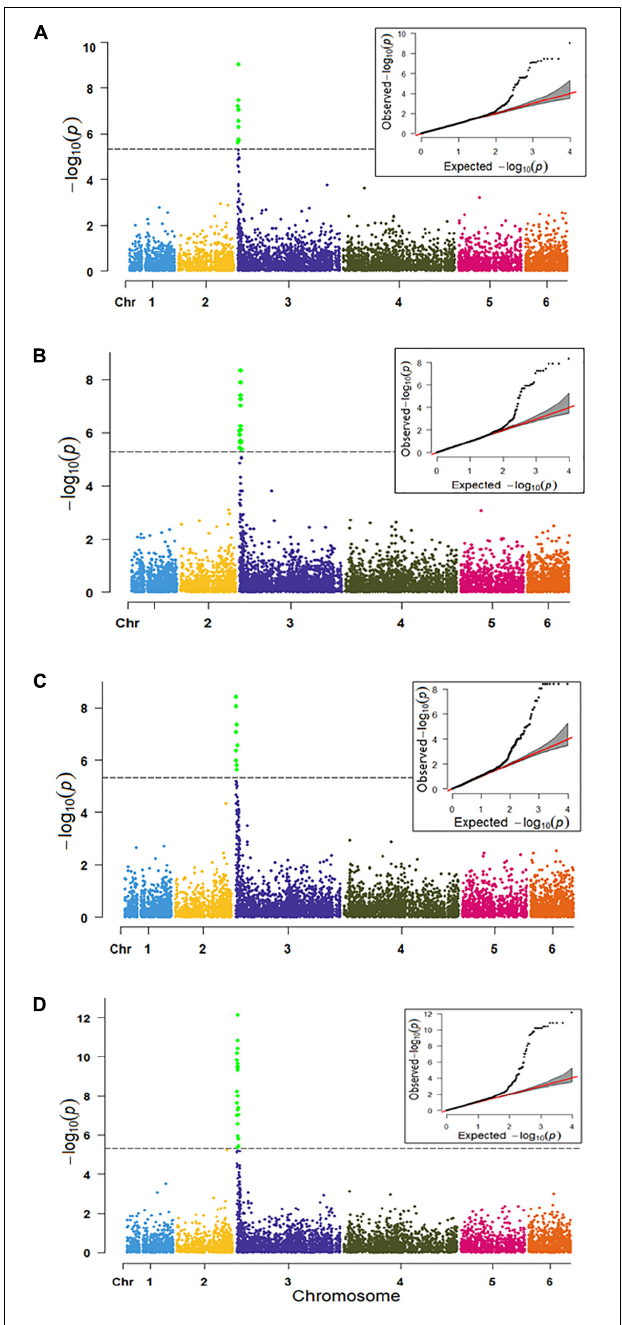
FIGURE 5 | Manhattan and QQ-plots of genome wide associations of the race 13 of P. effusa resistance in spinach in TASSEL (A) , GAPIT (B) , PLINK (C) , and GENESIS (D) model. The horizontal and vertical axis represents the genomic position of the SNP and association power for each SNP with the trait expressed as –log 10 ( P -value). The dashed line shows the Bonferroni-corrected genome wide threshold.